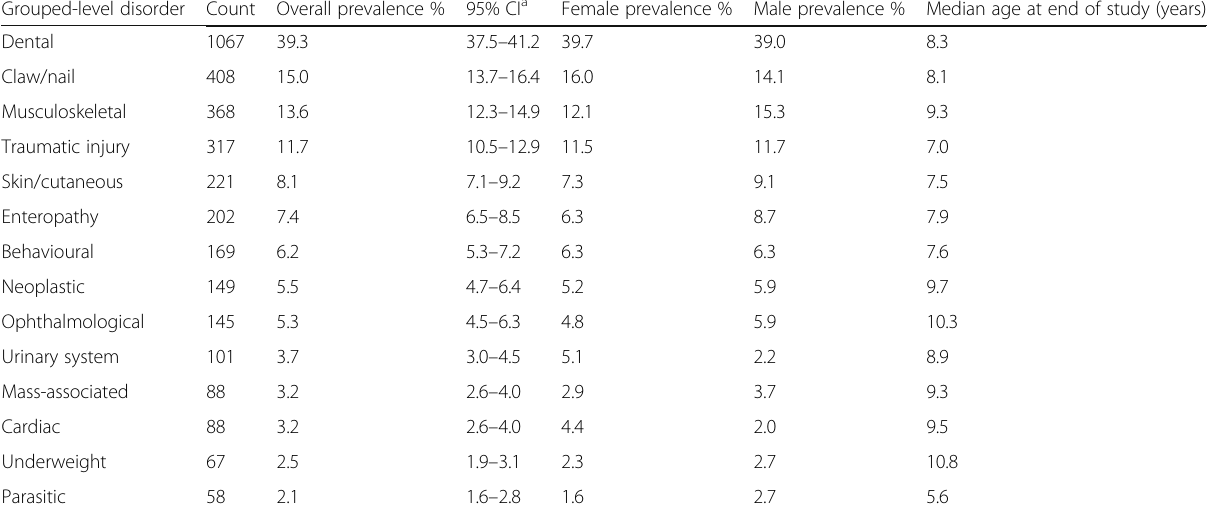
Table 4 Prevalence of the most common disorders at a grouped-level of diagnostic precision recorded in greyhounds (n = 2715) attending UK primary-care veterinary practices participating in the VetCompass ™ Programme from January 1st to December 31st,